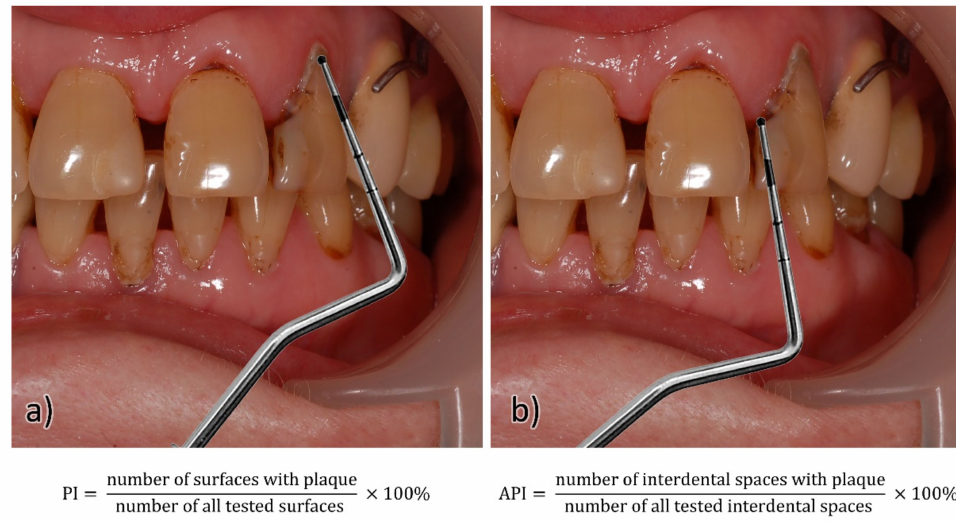
Figure 1. Scheme used for assessing the presence of plaque on the ( a ) smooth surface of the tooth (PI) and ( b ) in the interdental space (API). Equations show indices